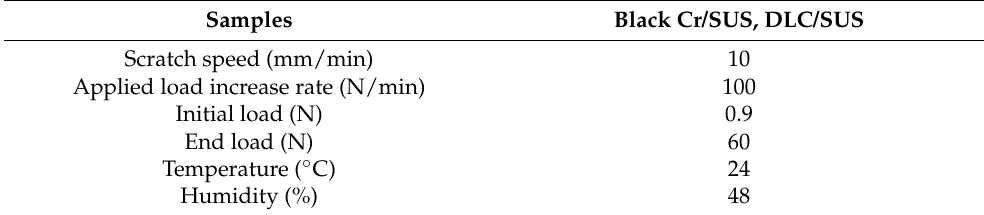
Figure 2. Schematic of the scratch test to measure adhesion. Table 1. Scratch test conditions. Table 1. Scratch test